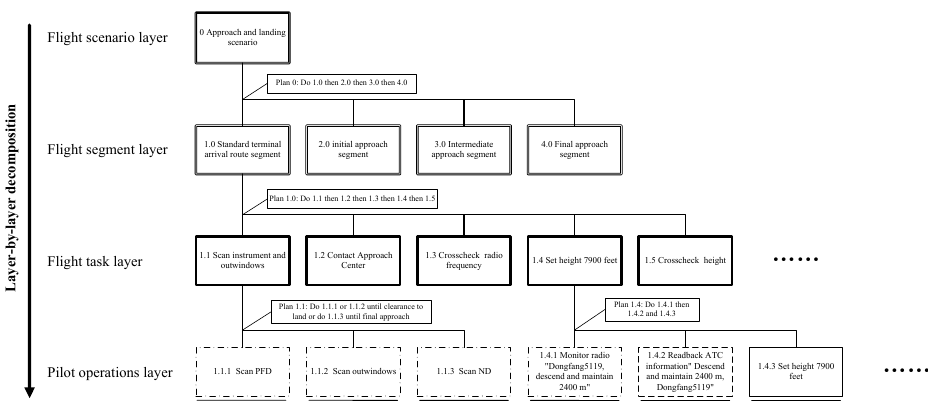
Figure 2. Layers of the current two-crew operations